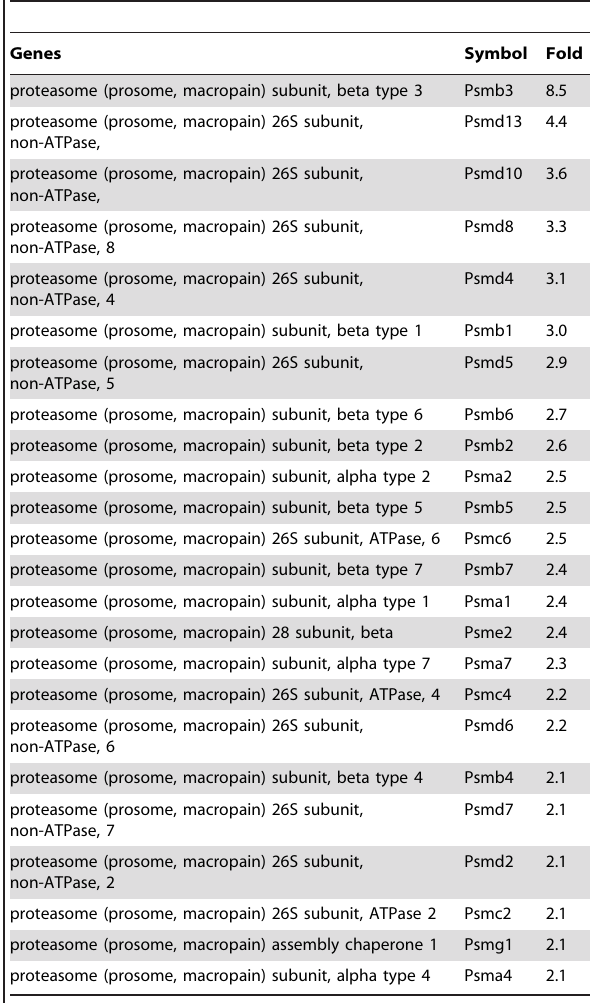
Table 7. Gene expression changes of ubiquitination related proteins in lal 2 / 2 bone marrow MDSCs.